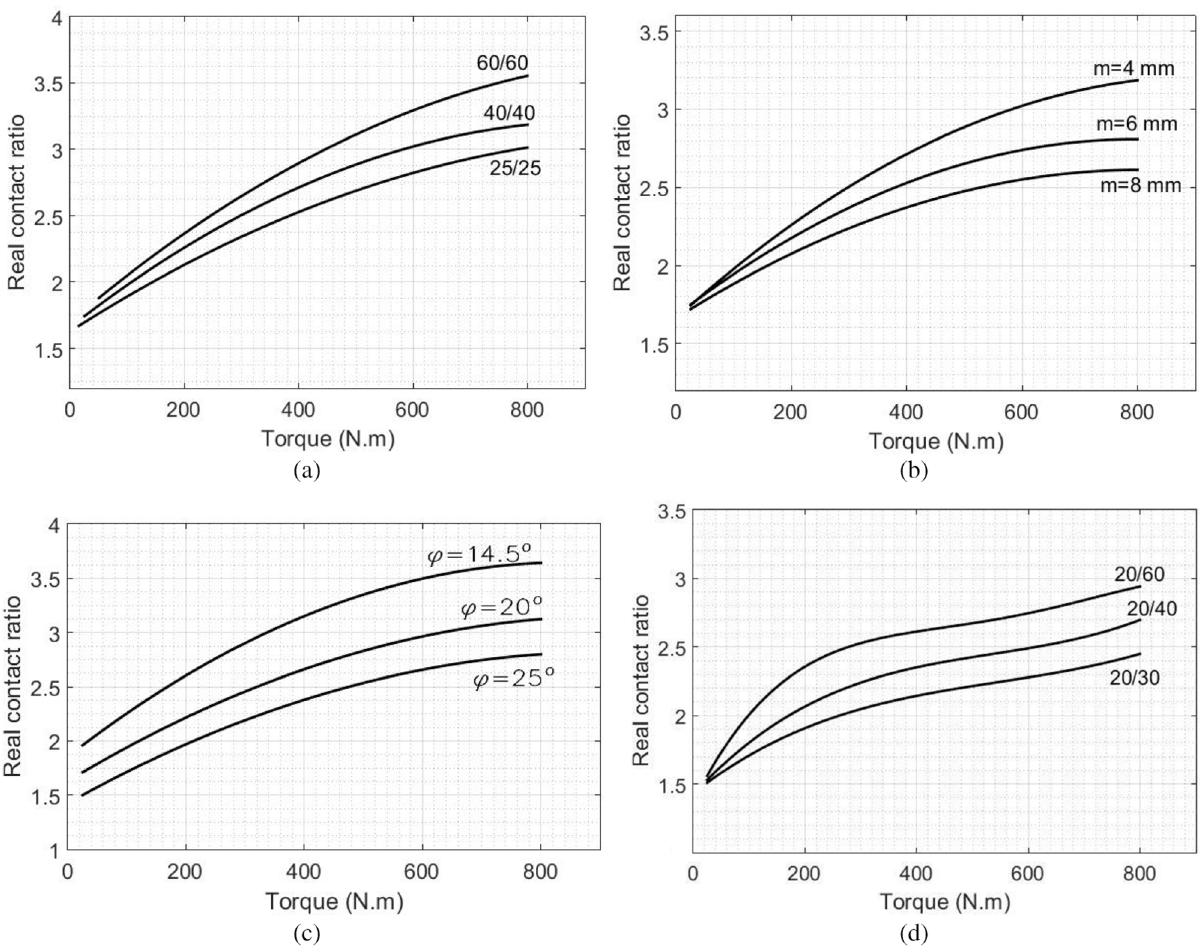
Fig. 14. Effect of gear parameters on the variation of the real contact ratio as a function of the applied